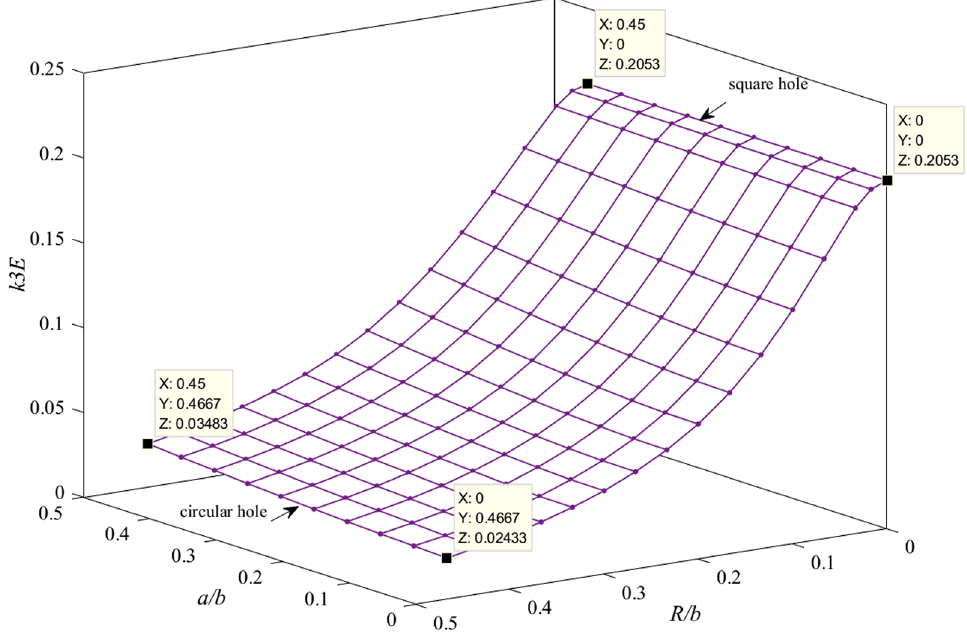
Fig. 20. The relationship between the reduction coef fi cient and the geometric parameters of the square plate with fi llet square hole ( t =